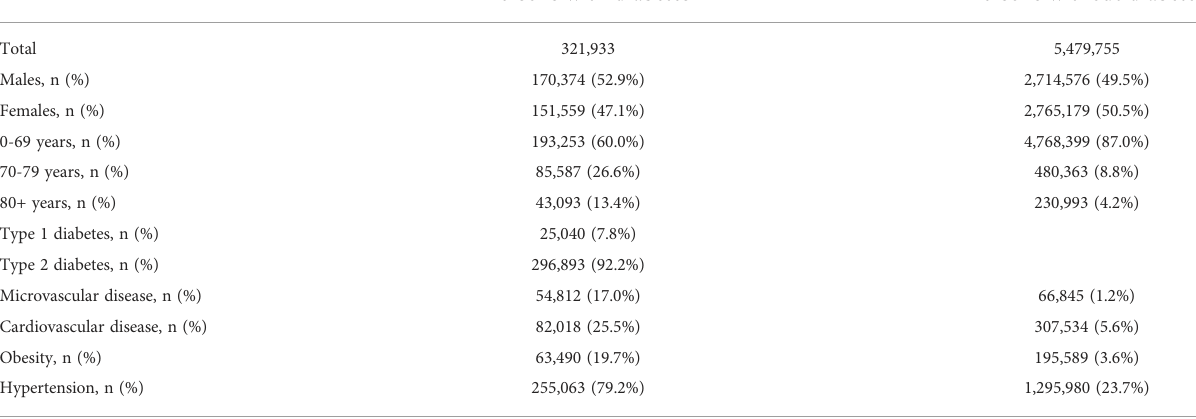
TABLE 1 Basic characteristics of all persons with and without diabetes in